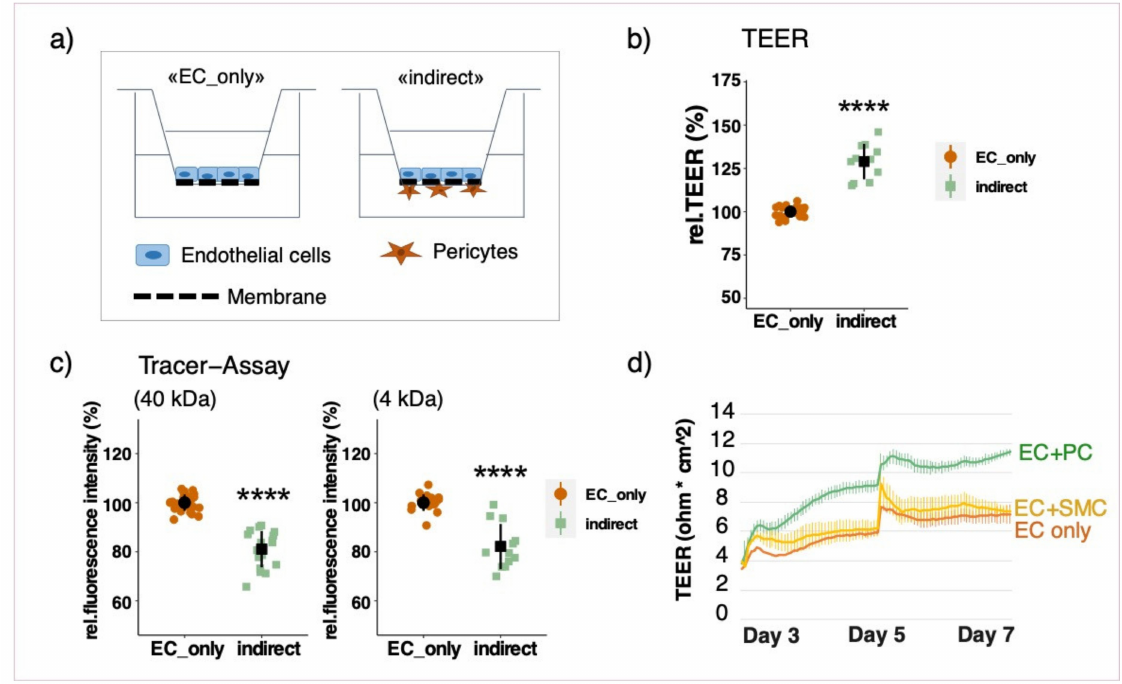
Figure 2. Pericytes (PCs) increase barrier function of endothelial cells (ECs). Schematic representation of the indirect co-culture model ( a ) ECs were cultured on transwell inserts alone (EC_only) or with PCs (indirect) ( b , c ) and SMCs ( d ) on the basolateral side of the insert (indirect). Cells were cultured for 7 days before barrier function was assessed. Relative trans-endothelial electric resistance (TEER) measurements were performed with a CellZcope instrument ( b ) . Relative fluorescence intensity measured by macromolecular tracer assay with FITC-labeled dextran molecules of 40 and 4 kDa ( c ). Representative real-time TEER measurement of ECs alone and in co-culture with PCs or SMCs ( d ). Experiments were performed at least three times in triplicates and data represent mean ± sd. **** p < 0.0001, compared to